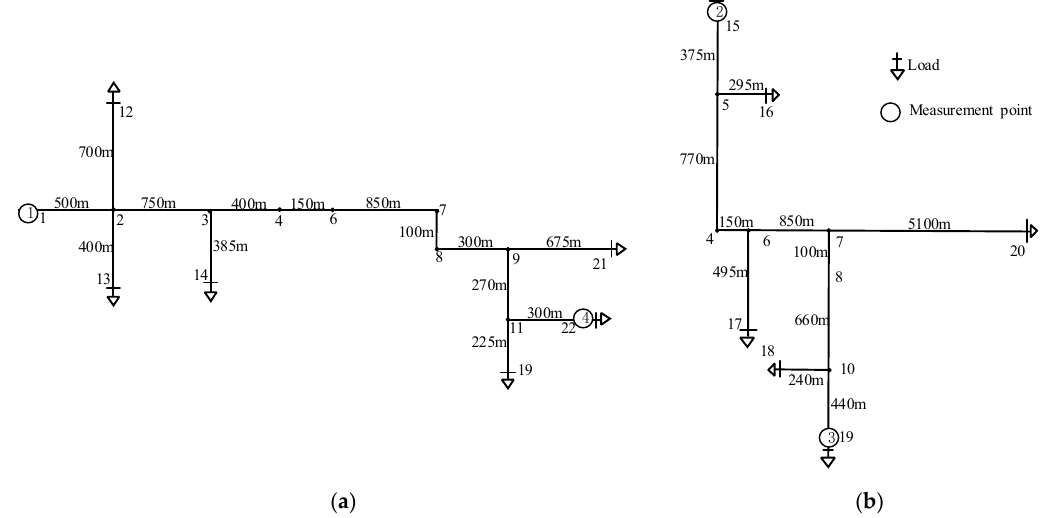
Figure 9. Sub-networks derived from Figure 8. ( a , b ) are two divided sub-networks.